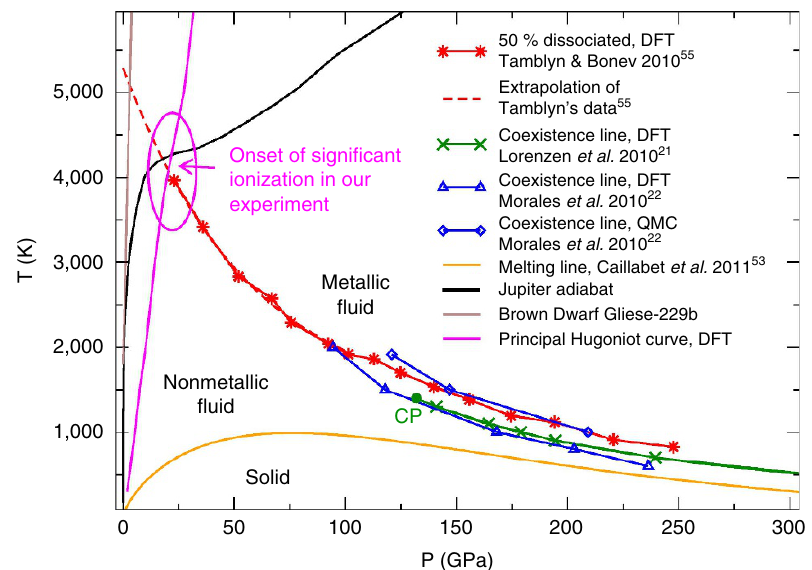
Figure 1 | Phase diagram of hydrogen. Displayed are the melting line 53 (orange), the isentropes of Jupiter 2,23 (black) and the Brown Dwarf Gliese-229b (ref. 54) (brown), the principal Hugoniot curve (magenta) and results for the first-order liquid–liquid (plasma phase) transition (green 21 and blue 22 ) together with predictions at which P – T points the system is dissociated by 50% (ref. 55)